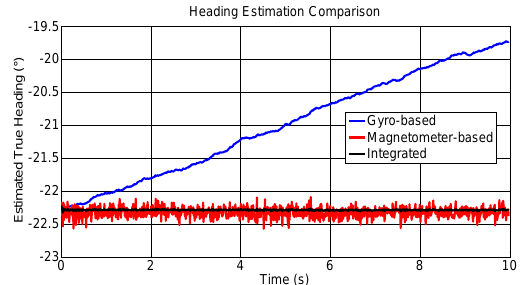
Figure 2. Heading estimation comparison between the gyro- based (blue), the magnetometer-based (red) and the developed